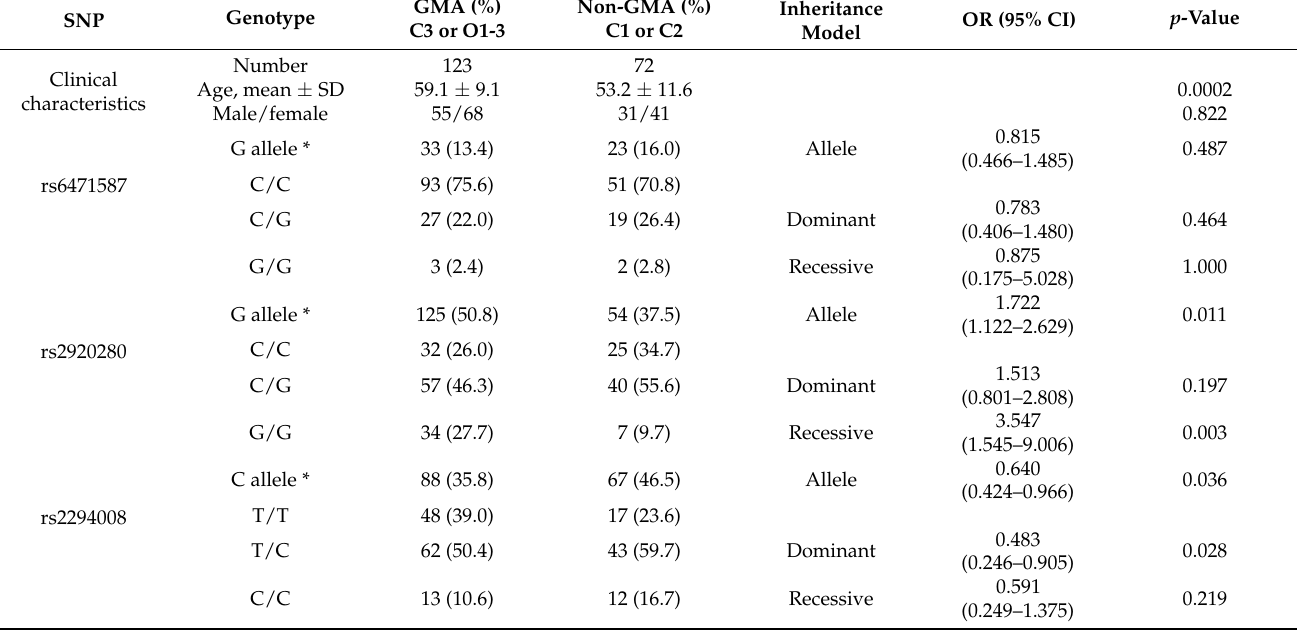
Table 3. Frequencies of alleles and genotypes of tag SNPs in PSCA for the GMA and non-GMA groups under the Kimura–Takemoto